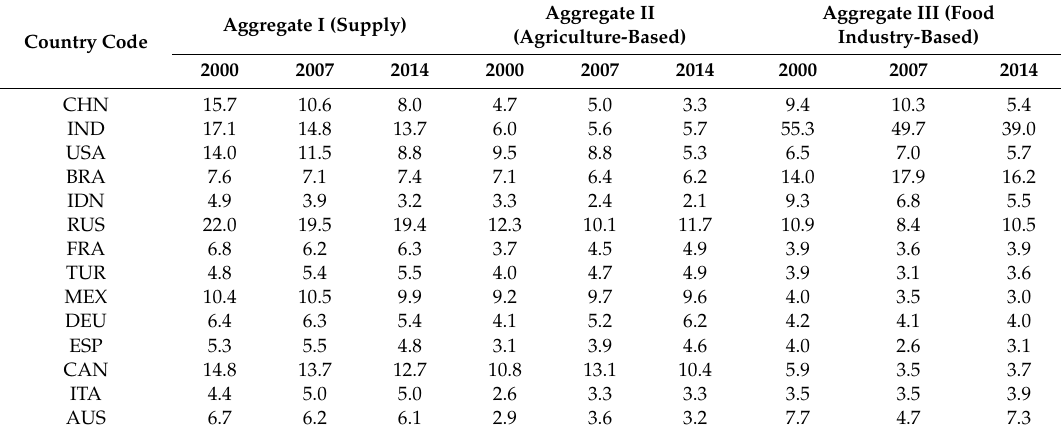
Table 2. Energy intensity of particular aggregates of food production systems in the selected countries (MJ / USD 1 worth of GDP at 2010 constant